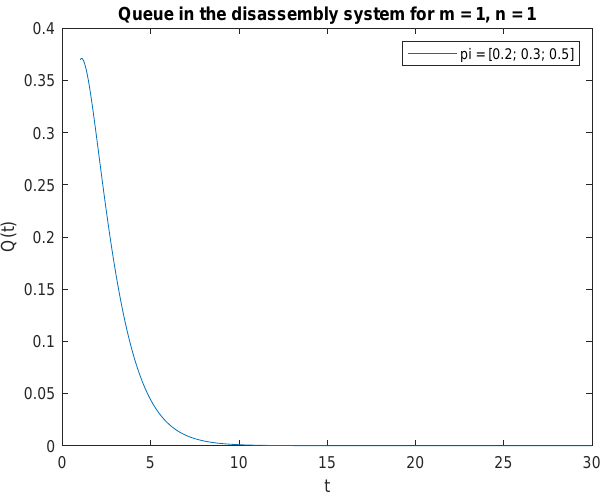
Figure 22. Impact of traffic load described by p i = { 0.2,0.3,0.5 } on P { X ( t ) = m = 1 | X ( 0 ) = n = 1 } for λ =